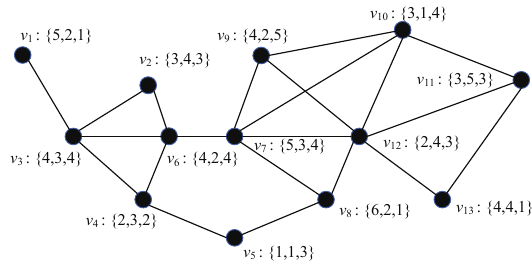
Fig. 1 Example of skyline